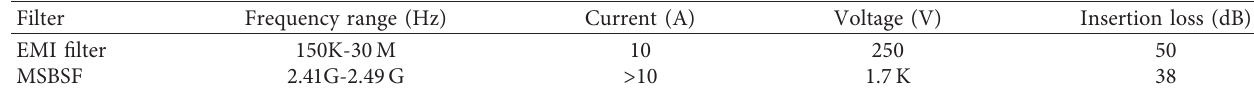
Table 4: Comparison between MSBSF and EMI